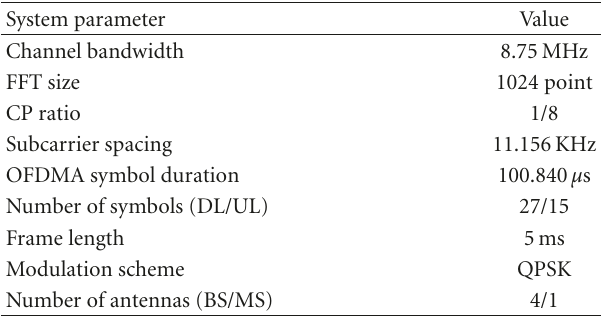
Table 1: System parameters of the implemented m-WiMAX SA BS. System parameter